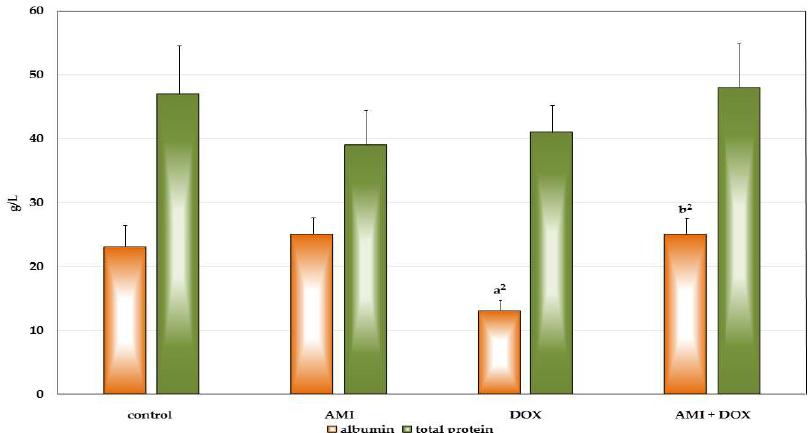
Figure 2. The influence of the treatment with amifostine and/or doxorubicin on albumin and total protein serum content 28 days after receiving last treatment. a 2 — p < 0.01 in comparison to the control group; b 2 — p < 0.01 in comparison to the DOX-only treated group.